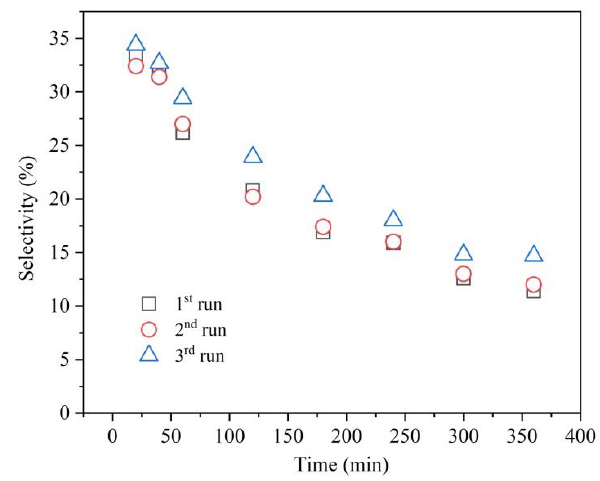
Figure 7. Cycling runs in photocatalytic oxidation of HMF over electrochemically synthesized TiO 2 .